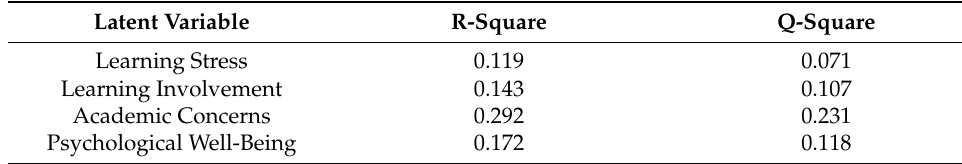
Table 4. Determination coefficient and predictive correlation.